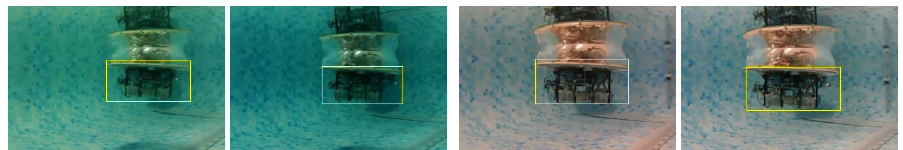
Figure 28. Images of First-level follower perspective and follower perspective of the three-robot “round-up hunting” formation experiment.